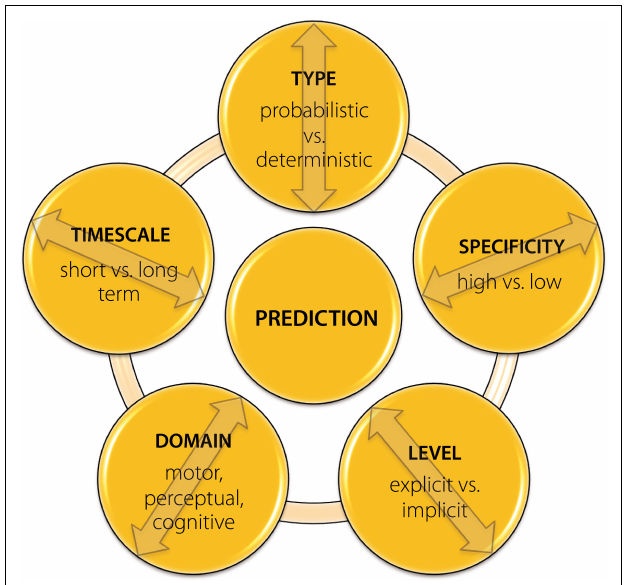
FIGURE 2 | Main factors which specify the nature of predictive processes across different contexts. It is important to note that these do not represent mutually independent and orthogonal dimensions, but may in some contexts strongly overlap and interact. Furthermore, some additional features such as, e.g., type of information used for formulating expectations, might also be of relevance when specifying the exact nature of the predictive phenomenon of